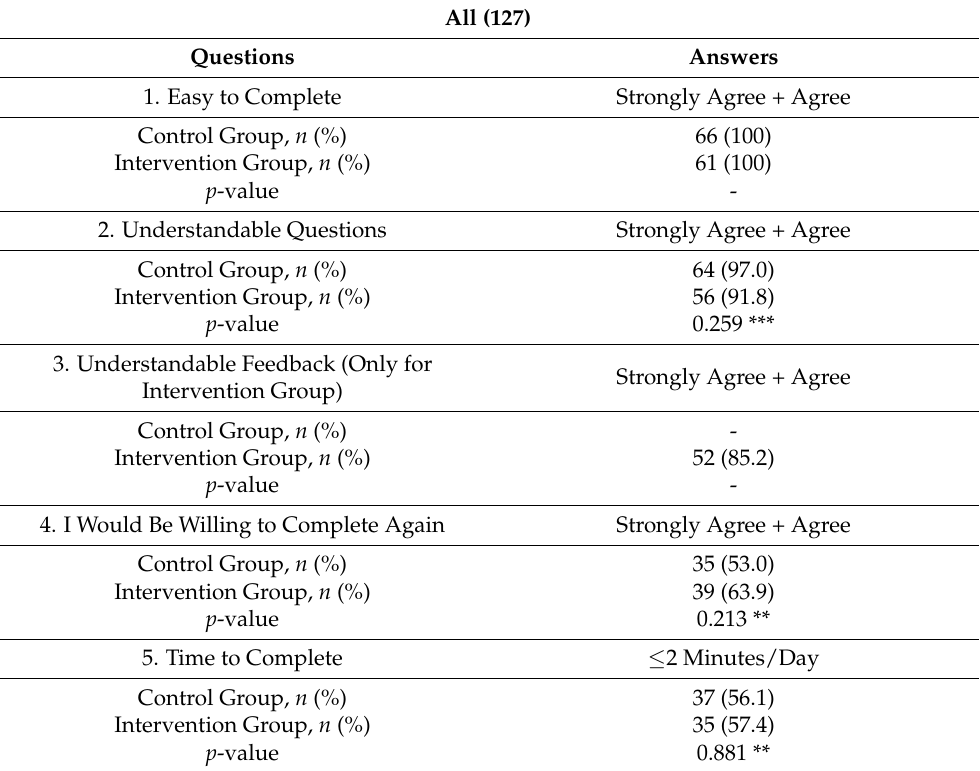
Table 5. Responses to the Usability Rating Questionnaire for